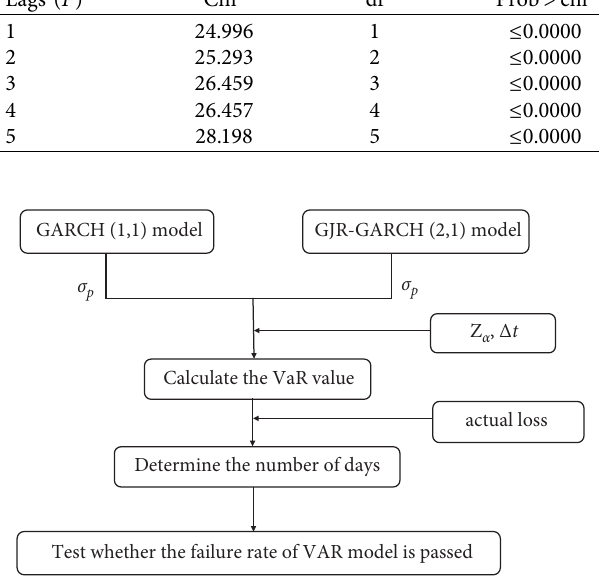
Figure 2: Process chart of dynamic risk measurement of China’s soybean futures price. Table 4: Estimation of GARCH (1, 1)